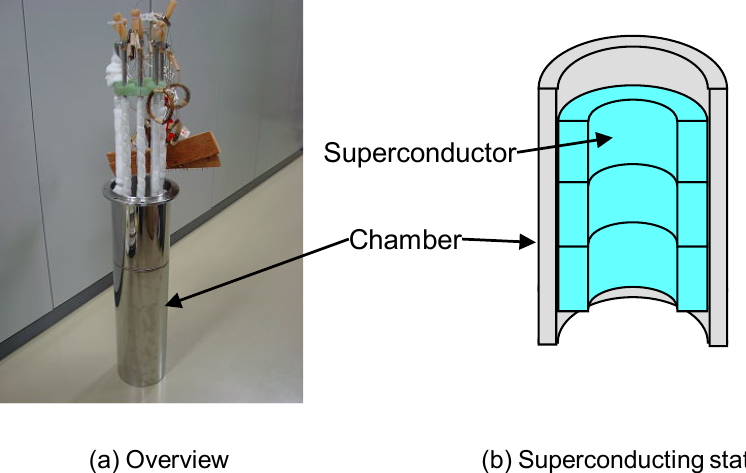
Figure 2. Superconducting stator representing ( a ) an overview photo of the stator and ( b ) the structure of the superconducting stator.